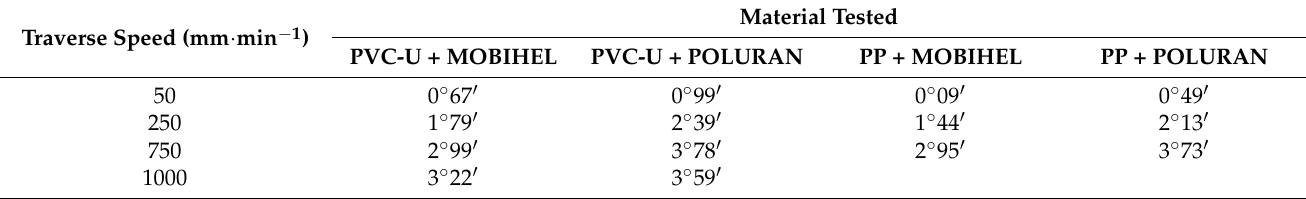
Table 3. Calculated values of the taper angle of the cutting gap depending on the traverse speed of the waterjet cutting head. Traverse Speed (mm · min − 1